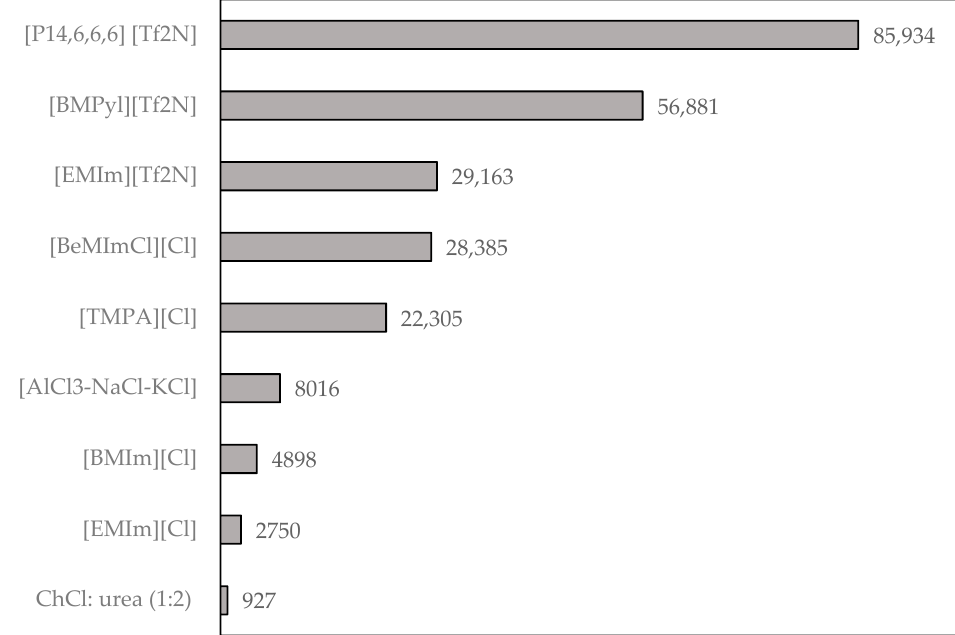
Figure 8. Plot showing the cost comparison of the ionic liquid-based systems and an inorganic molten temperature salt system for the deposition of Al considering the initial make up of 100 L solution.